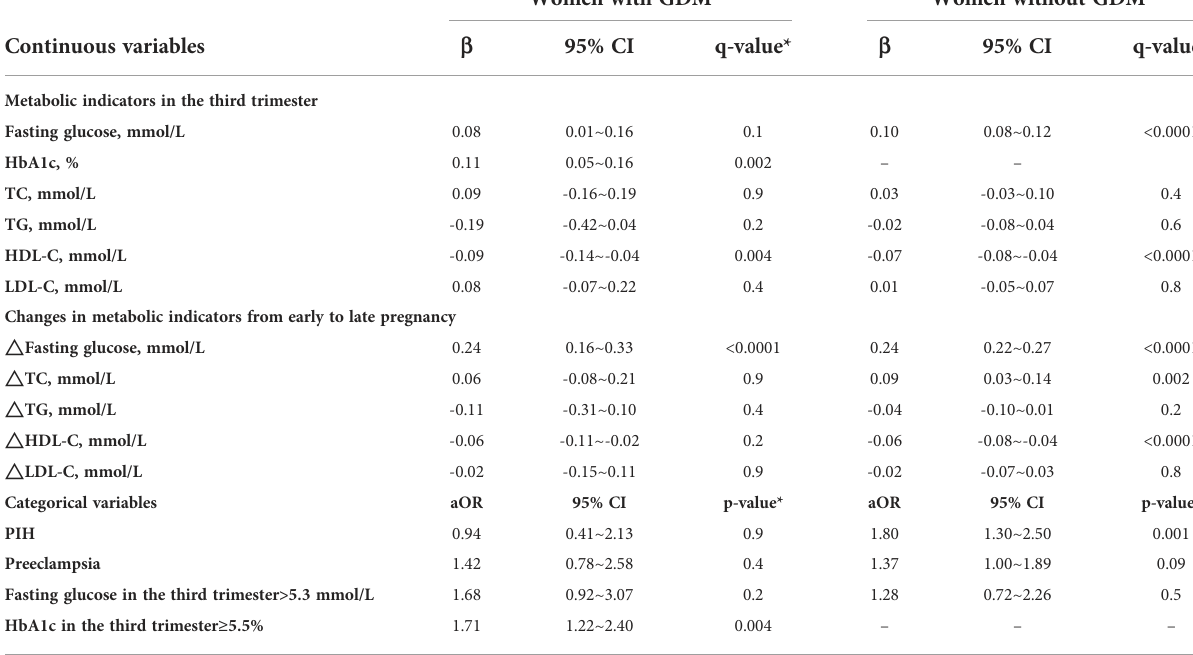
*Regression coef fi cients for metabolic indicators in the third trimester and aOR for the categorical variables were calculated adjusted for age, pre-pregnancy BMI, gravidity, parity, glucose level during OGTT, family history of hypertension, and family history of diabetes; regression coef fi cients for changes of metabolic indicators were adjusted for age, pre-pregnancy BMI, gravidity, parity, family history of hypertension, and family history of diabetes. HbA1c, glycosylatedHemoglobin; TC,total cholesterol; TG,triglyceride; HDL-C, high density lipoprotein cholesterol; LDL-C, lowdensity lipoprotein cholesterol; PIH,pregnancy induced hypertension; BMI, body mass index; OGTT, oral glucose tolerance